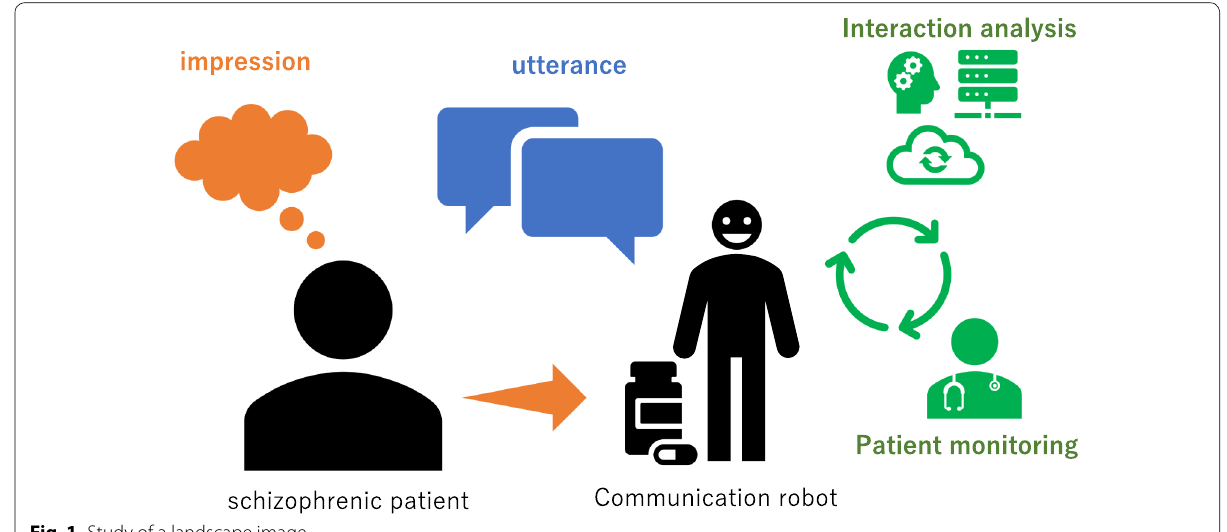
Fig. 1 Study of a landscape